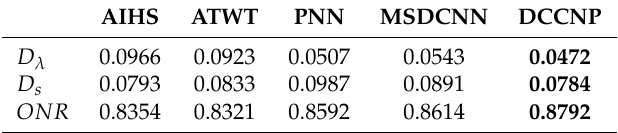
Table 4. Quantitative assessments of real experiments on QuickBird